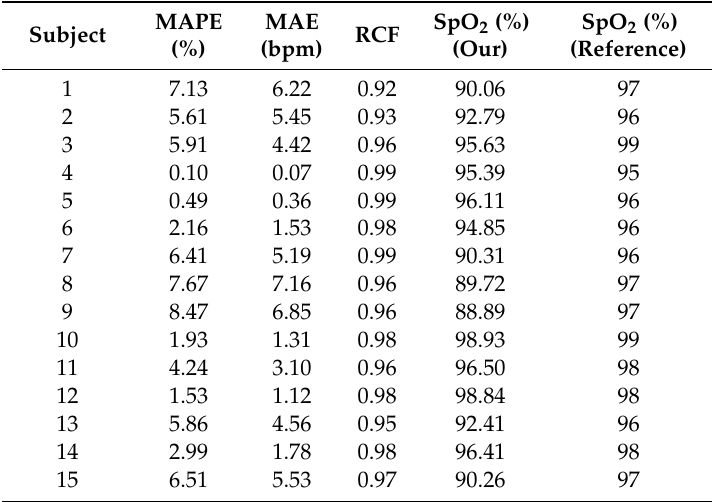
Table 5. Performance of our proposed wearable pulse oximeter device for the round-up finger motion condition.